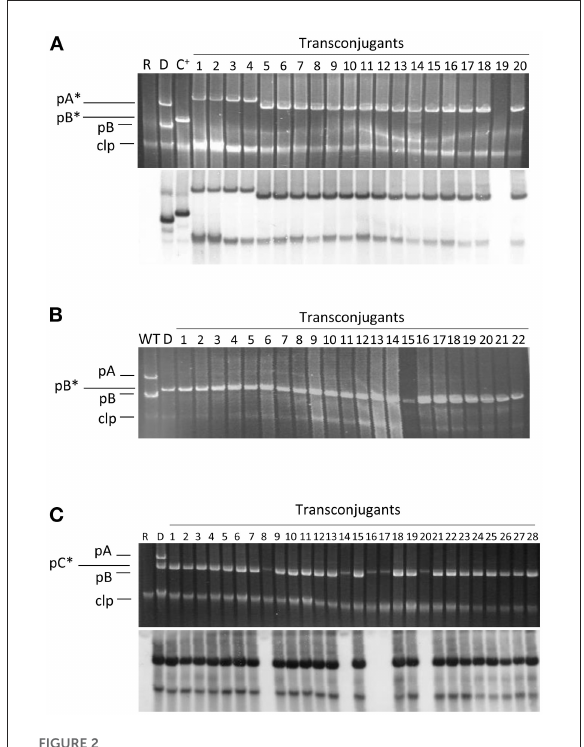
FIGURE2 Plasmid profiles of transconjugants and their hybridization to a probe specific for pB. Conjugation was carried out on solid minimal medium A using the plasmidless strain 1 ABCTc as recipient and as donors the following strains: (A) strain NCPPB 3335 containing pPsv48A::Tn 5- GDYN1 (pA*); (B) strain 1 ABC containing pPsv48B::Tn 5- GDYN1 (pB*); (C) strain NCPPB 3335 containing pPsv48C::Tn 5- GDYN1 (pC*). The bottom picture in (A,C) correspond to the gels shown above after being subjected to Southern hybridization using as probe a region from pB (positions 14062..15310, accession no. FR820586) not repeated elsewhere in the genome of strain NCPPB 3335. WT, wild type strain NCPPB 3335; D, donor strain; R, receptor strain 1